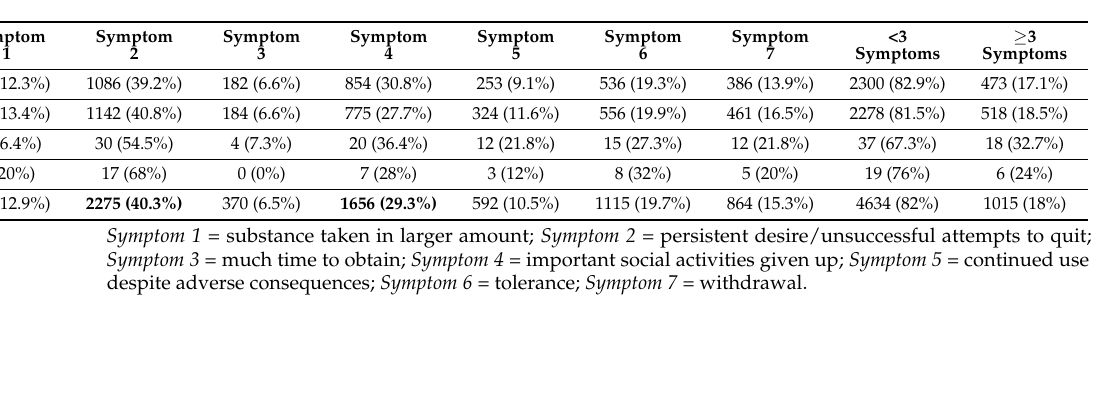
Table 3. Yale Food Addiction Scale (YFAS-C) symptom criteria endorsement by gender for the total sample reported as frequency